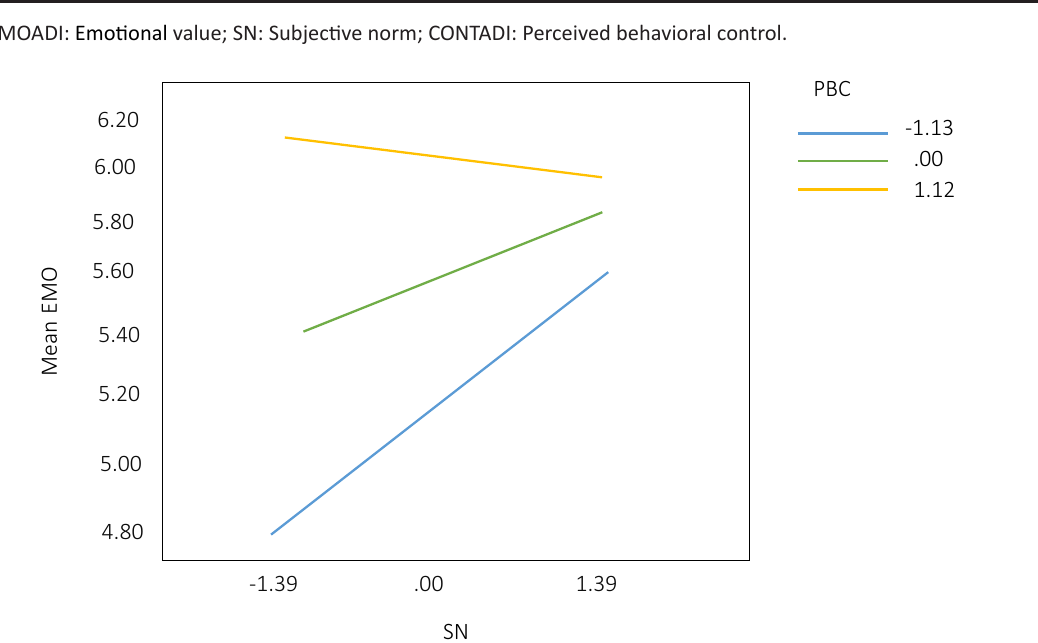
Figure 3. Moderating effects of perceived behavioral control on the relationship between subjective norm and purchase intention (through emotional value)